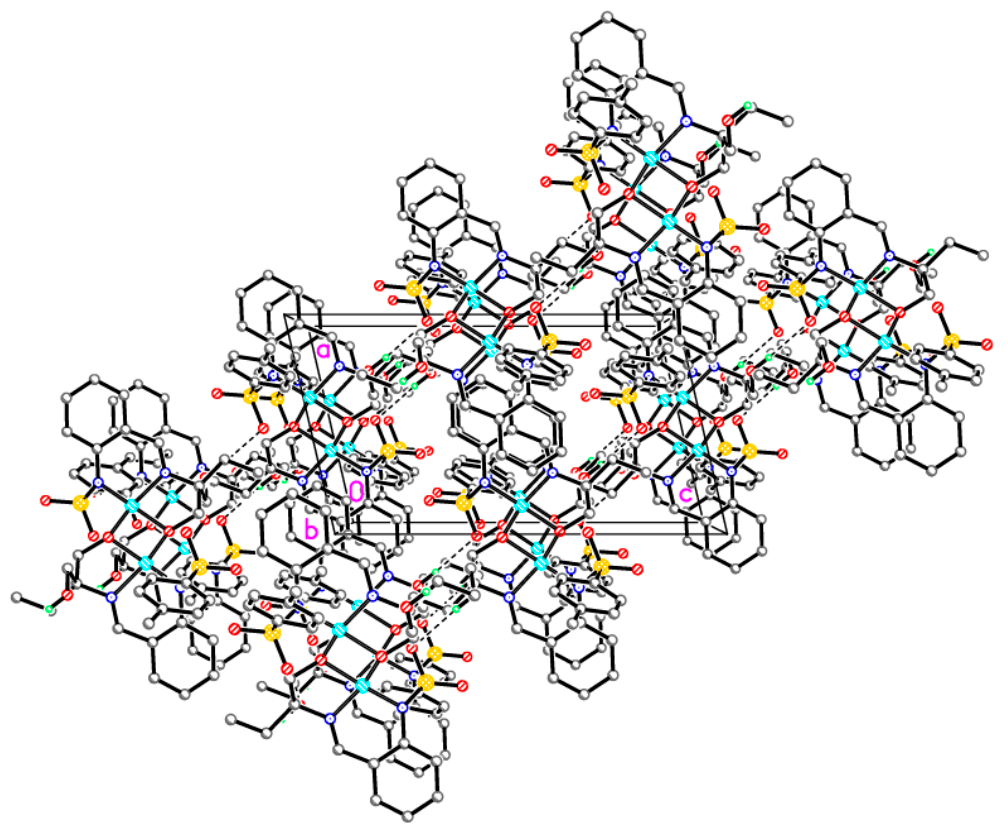
Figure 7. Crystal packing of 3-Cu demonstrating the H-bonded layers parallel to (1 0 1).